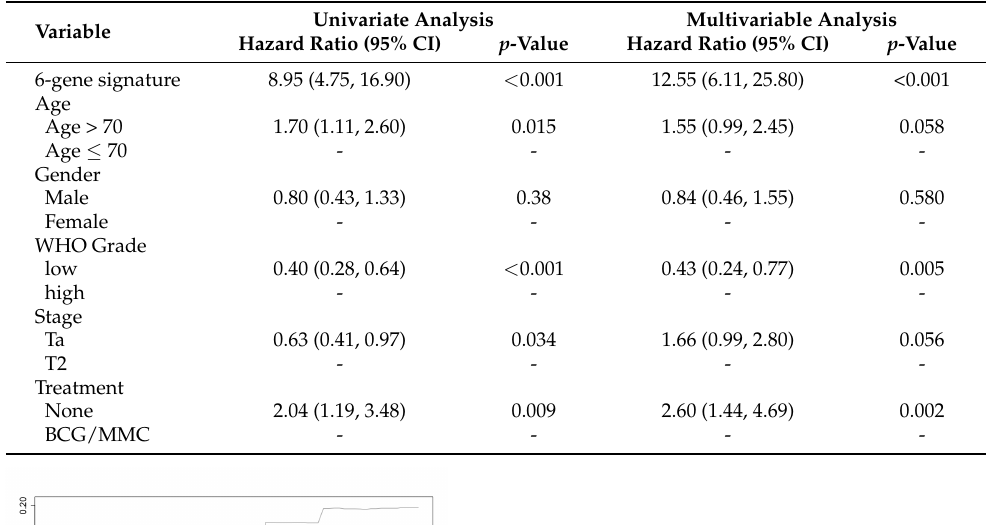
Table 3. Hazard ratio estimates, 95% confidence intervals (CI) and p -values for the 6-gene signature (identified by PSH-CSIS+CoxBoost) and other clinical covariates, corresponding to cumulative incidence function of Cause 1 (progression, or death from bladder cancer), obtained from fitting the univariate or multivariable competing risks Cox regression.